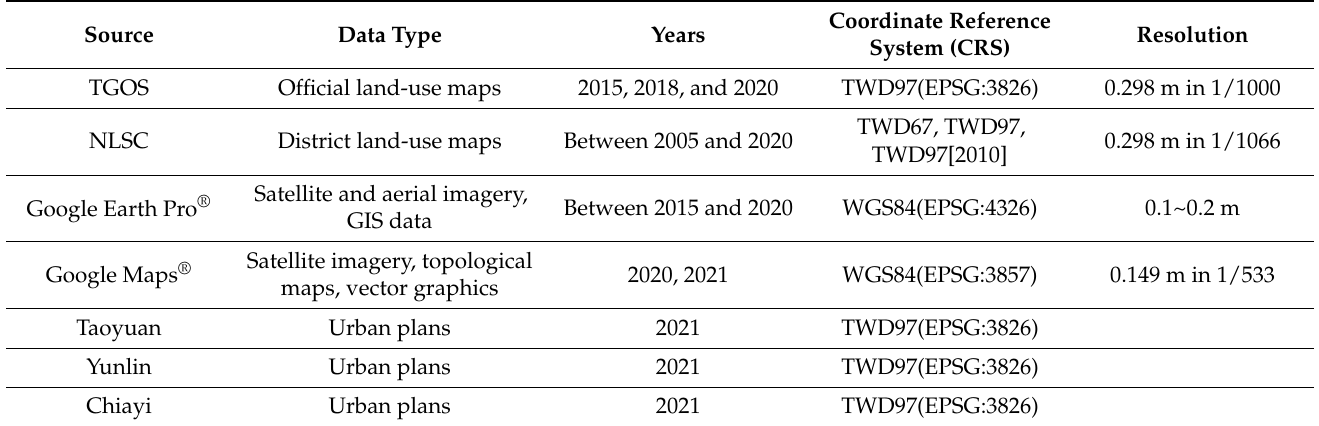
Table 1. The five types of maps, images, and plans